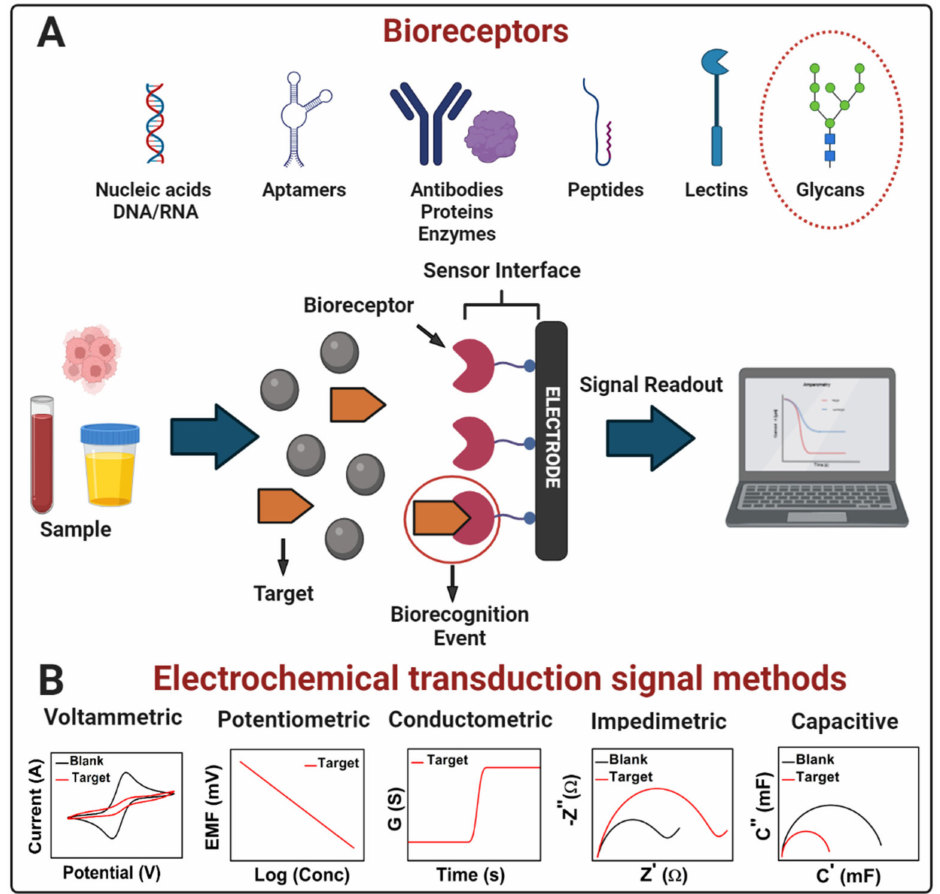
Figure 1. ( A ) Scheme of a generic electrochemical biosensor. A bioreceptor (nucleic acids, aptamers, antibodies, proteins, enzymes, peptides, lectins, glycans, etc.) attached to the electrode surface recruits the molecular target (analyte present in a sample) onto the sensor interface by an affinity reaction. After the bioreceptor binding with the target (biorecognition event), the transducer converts the binding event into a measurable signal proportional to the concentration of the target (signal readout). ( B ) Electrochemical transduction signal methods in biosensors: voltammetric, potentiomet- ric, conductometric, impedimetric, and capacitive. Adapted from [22] with permission. Copyright Elsevier